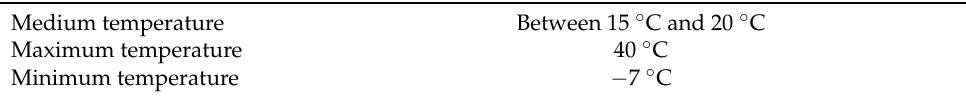
Table 4. Temperature values considered ideal for olive growing.